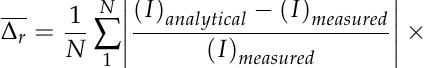
Figure 5. Comparison of the measured and analytical Reynolds stresses. Black squares denote the measured data and red lines denote the analytical